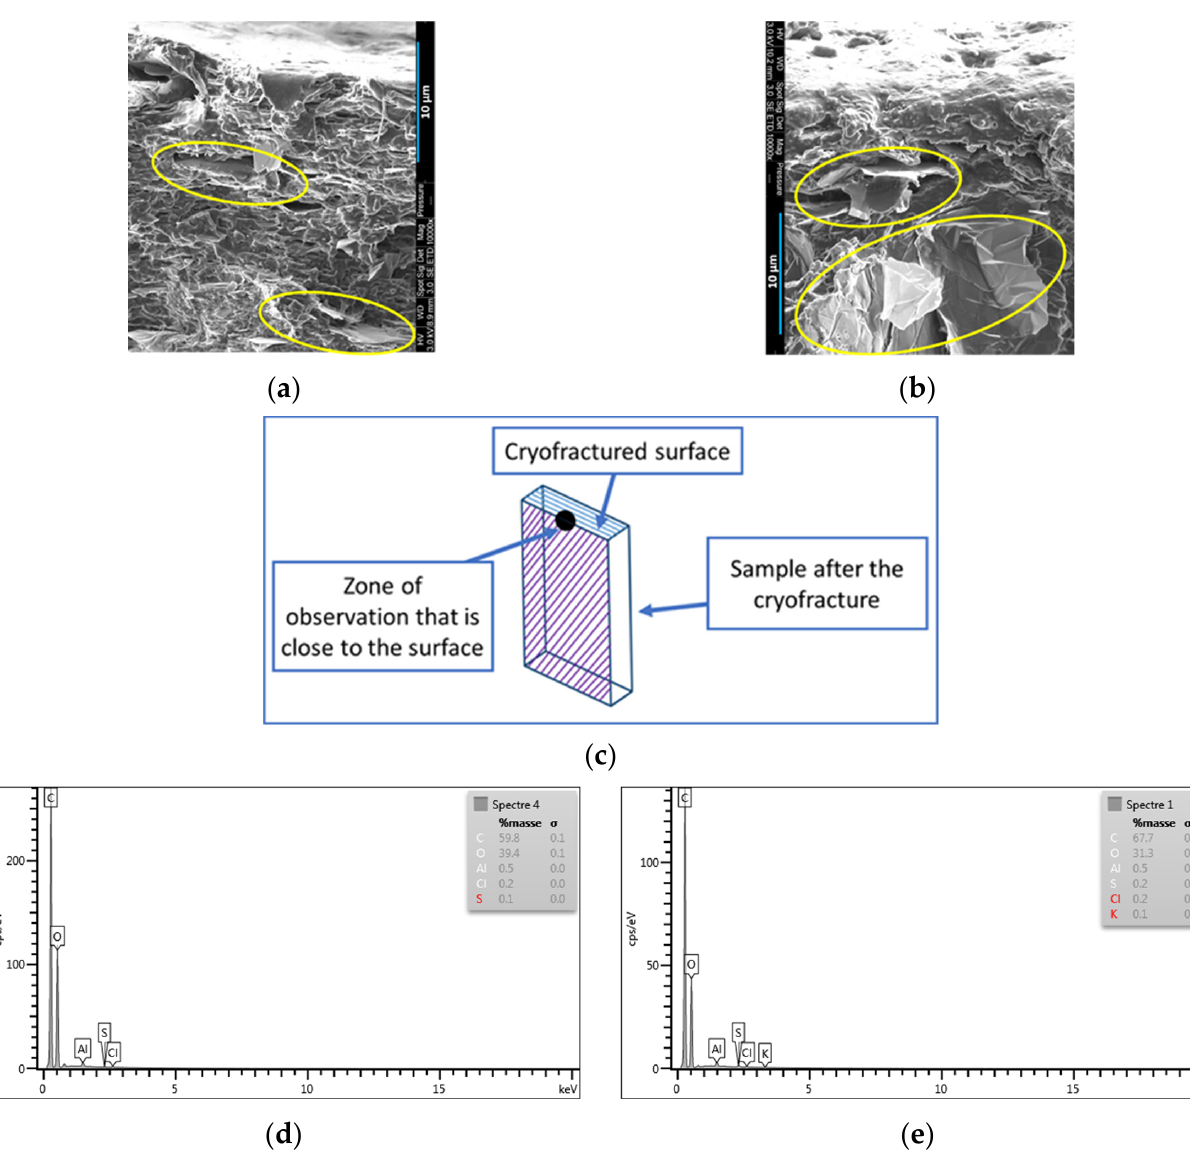
Figure 9. ( a ) SEM image of the injection-moulded PLA/PCL/15 wt.% M5 composite and its EDX ( d ); ( b ) SEM image of 3D printed PLA/PCL/15 wt.% M5 composite and its EDX ( e ); ( c ) the zone of observation where ( a ) and ( b ) were determined and indicated by the small black circle (the yellow circles surround some graphene flakes).